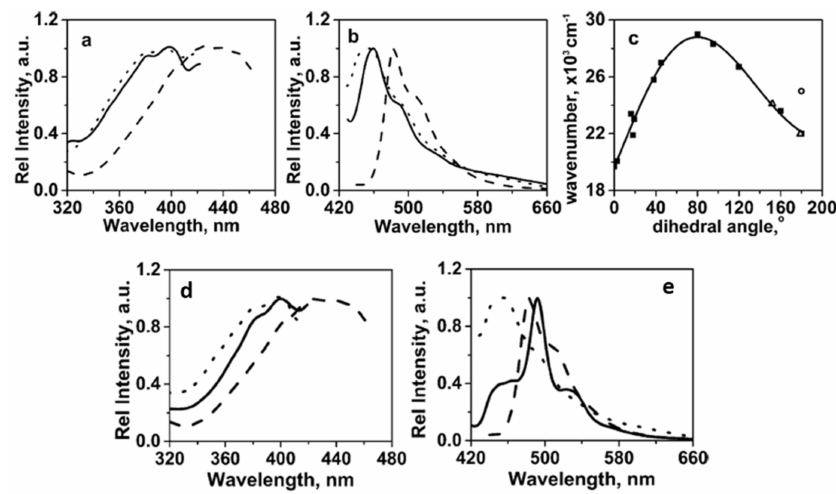
Figure 23. ( a ) Excitation and ( b ) emission spectra of a 5 wt% DODA in 1-octanol gel at 25 ◦ C (solid line, λ em = 458 nm, λ ex = 400 nm), sol at 45 ◦ C (dashed line, λ em = 481 nm, λ ex = 425 nm), and melt-solidified DODA at 25 ◦ C (dotted line, λ em = 458 nm, λ ex = 400 nm). ( c ) Dependence of the excitation wavenumber maxima on the inter-carbonyl dihedral angle of a series of α -diketo containing molecules at 25 ◦ C in solution (solid squares; republished from [90] with permission of The Royal Society of Chemistry); a 5 wt% DODA in 1-octanol gel at 25 ◦ C (open circle); a 5 wt % DODA in 1-octanol sol at 45 ◦ C (open triangle). The range of multiple excitation maxima of the 5 wt % DODA in 1-octanol sol is indicated by the curve between the two open triangles. ( d ) excitation, and ( e ) emission spectra at 25 ◦ C of gels of 5 wt % DODA in 1-octanol after incubating the sols at 0 ◦ C (dotted line, λ em = 458 nm, λ ex = 400 nm), 30 ◦ C (solid line, λ em = 458 nm, λ ex = 400 nm), and 45 ◦ C (dashed line, λ em = 481 nm, λ ex = 425 nm). Reproduced with permission from [44]. Copyright John Wiley and Sons.